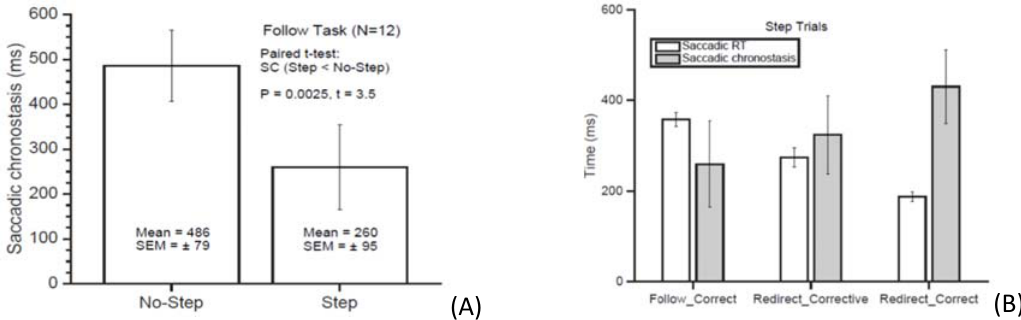
Figure 1. (A) Magnitude of saccadic chronostasis in the follow task during one saccade (no‐step) and two saccades (step). (B) Saccadic response time and chronostasis magnitude during consecutive saccades are compared in different cognitive